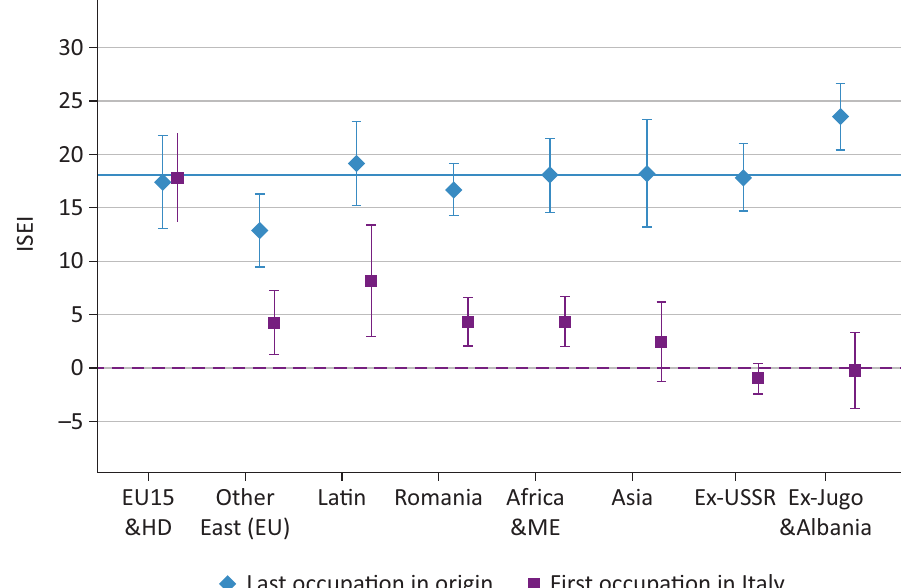
Figure 1. ISEI returns to post-secondary degree by area of origin (controls included, 95%